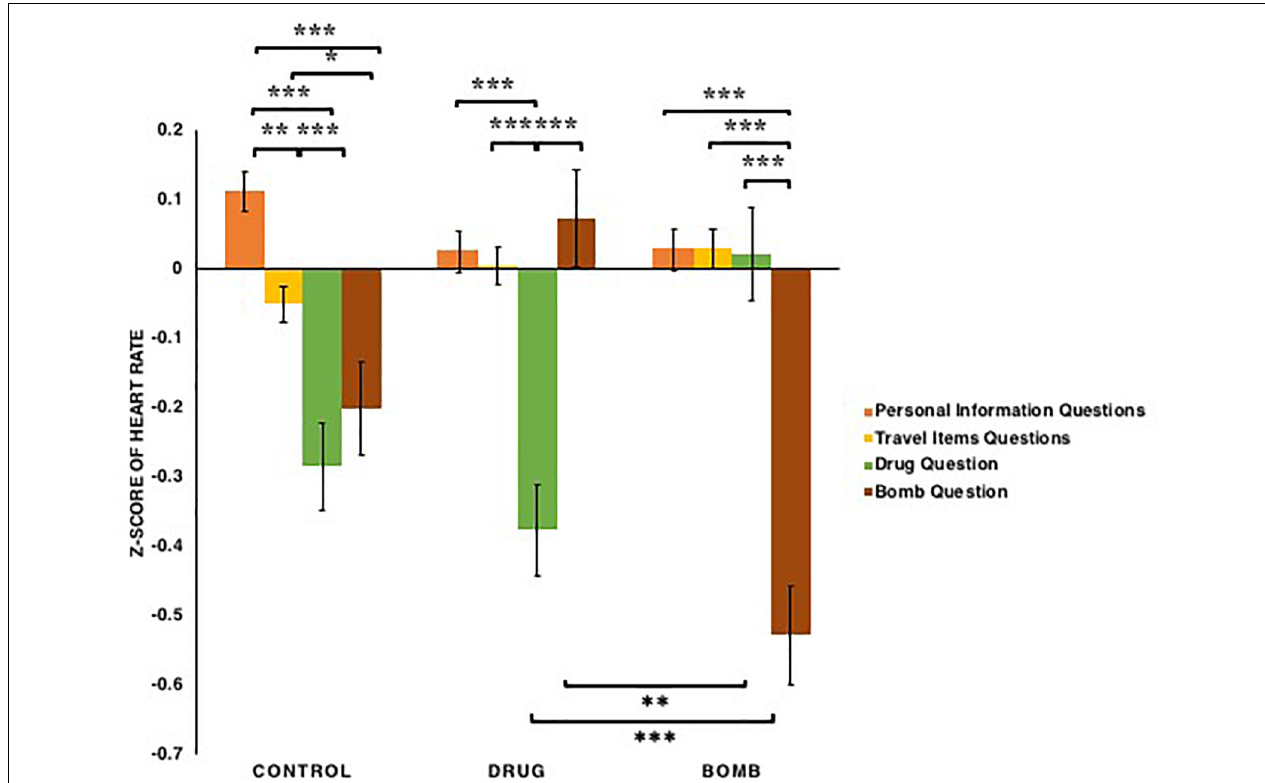
FIGURE 9 | The z -scores of heart rates among participants in the bomb, control, and drug conditions across the four types of questions: basic personal information, carrying common travel items, carrying drugs, carrying a bomb. Note that ∗ p < 0.05, ∗∗ p < 0.01, ∗∗∗ p < 0.001. The error bars